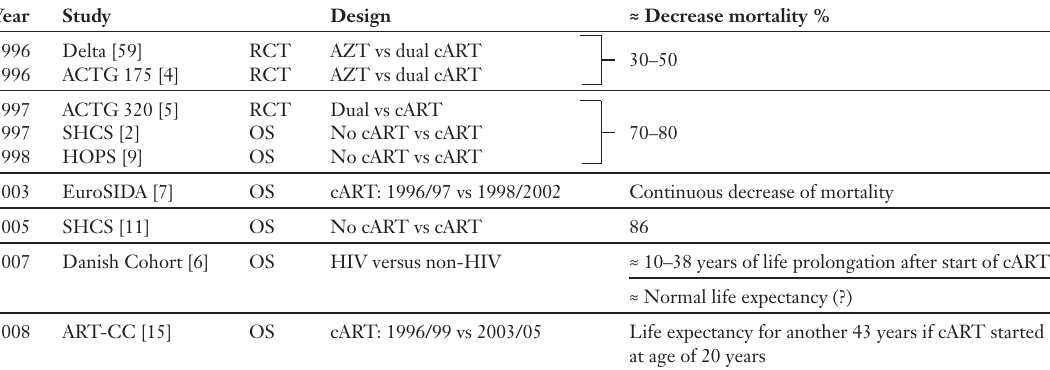
Combination anti- retroviral therapy has dramatically de- creased the mortality of HIV-infected individuals.